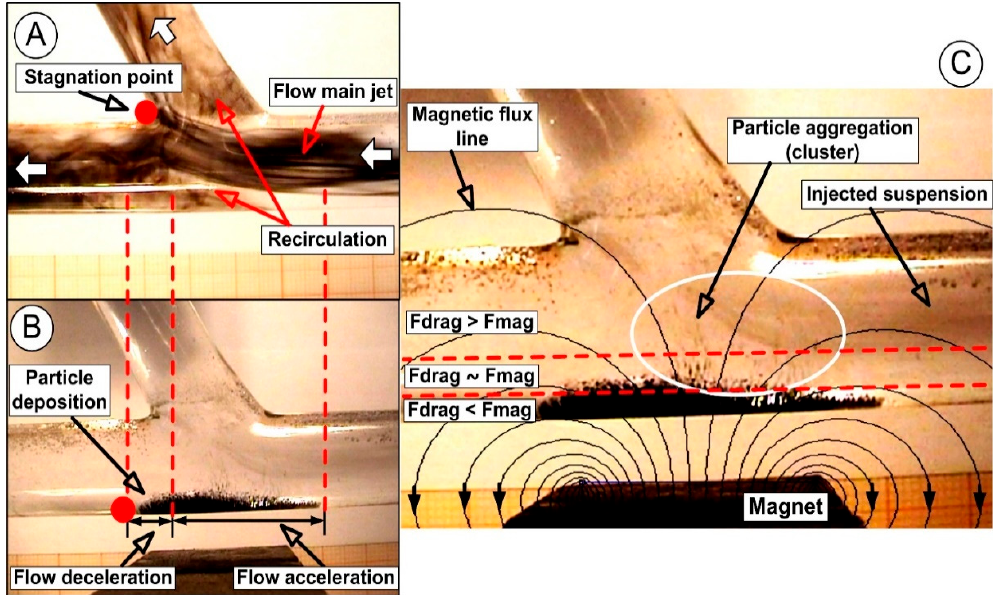
Figure 12. ( A ) Flow dynamics in the bifurcation region. ( B ) Particle deposition at the end of the injection time of 30 s. The distance between the permanent magnet and the bifurcation wall are 7 mm. ( C ) Magnetic and drag force distribution in the bifurcation region. The average intensity of the magnetic field along the bypass bottom wall was B = 0.05 T, according to Figure 9. In the case of comparable values of magnetic force and flow drag force, flow perturbation influences the FMP depositions, especially in the peripheral region.